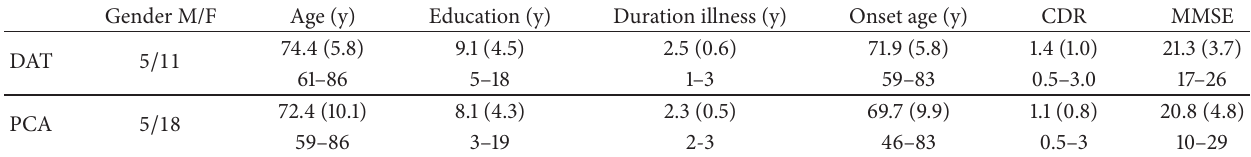
Table 1: Demographic and clinical data of DAT and PCA. Means (sd) and ranges are